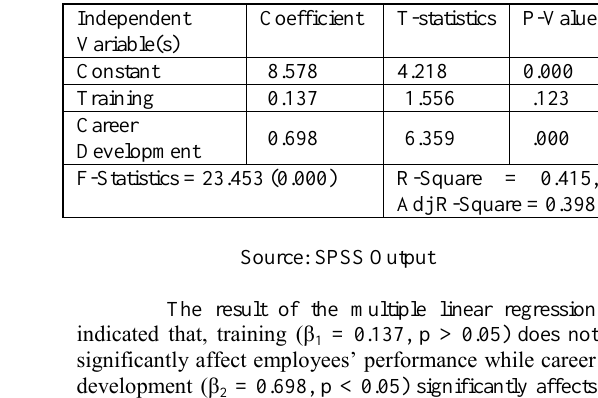
Table 4: Multiple Regression Result